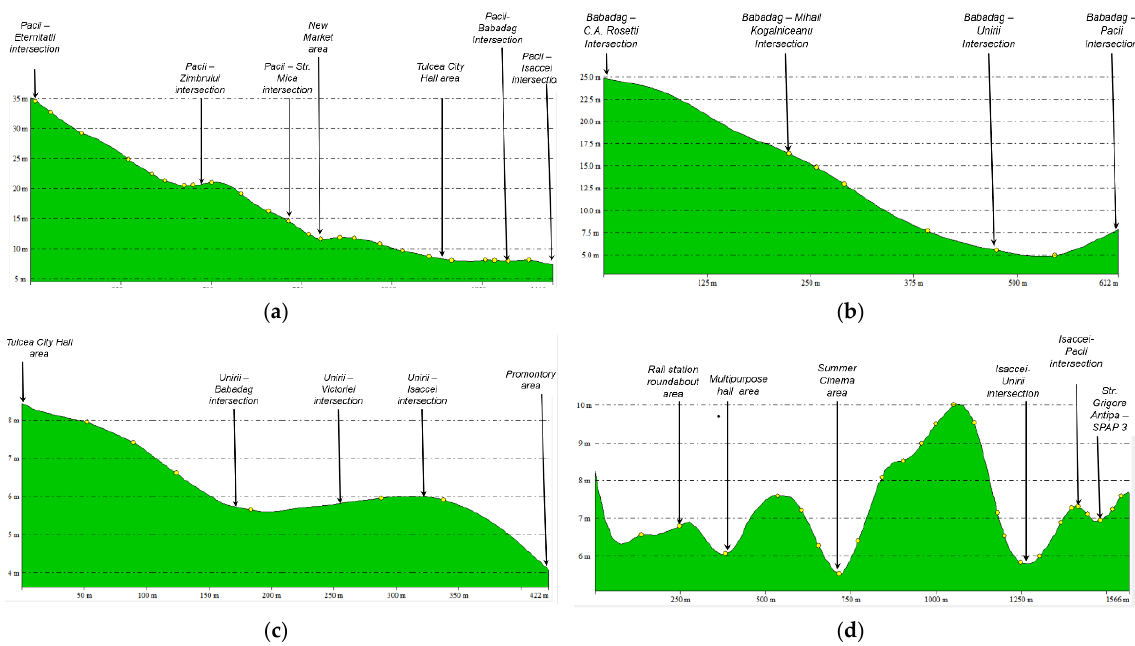
Figure 6. Main sensitive areas in case of pluvial floods and the corresponding main streets. A number of longitudinal profiles along the frequently flooded streets are provided in Figure 7.